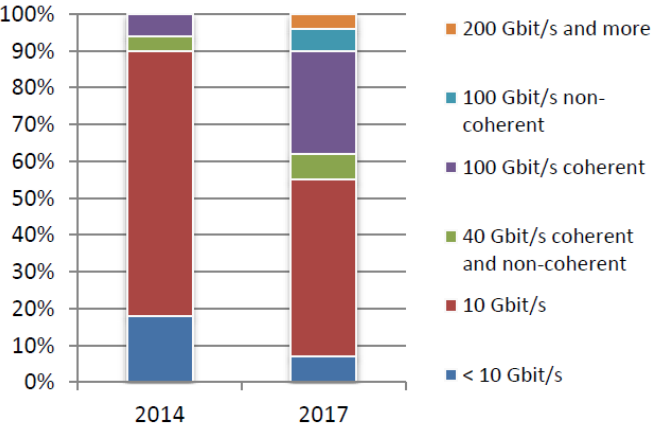
Figure 2. Evolution towards higher capacity channels in the metro network [12].